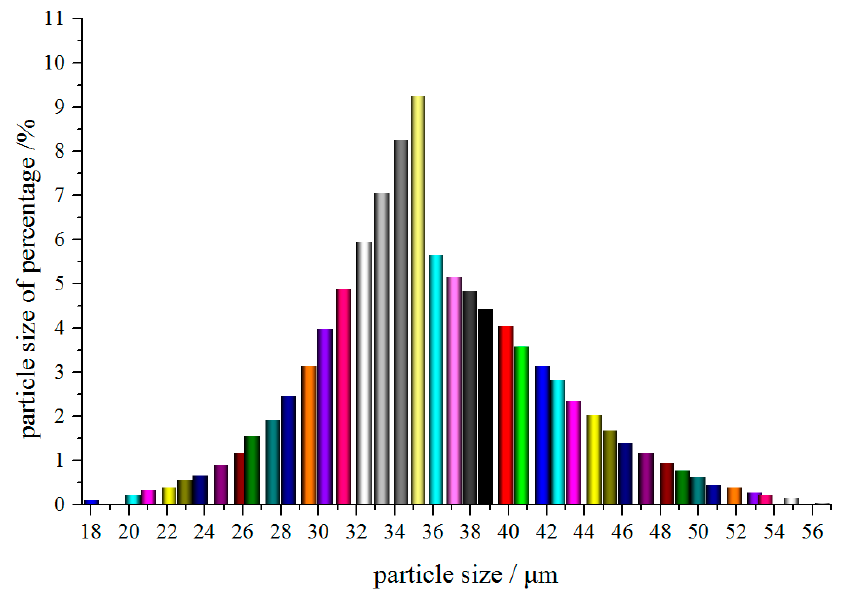
Figure 3. The water mist field histogram.